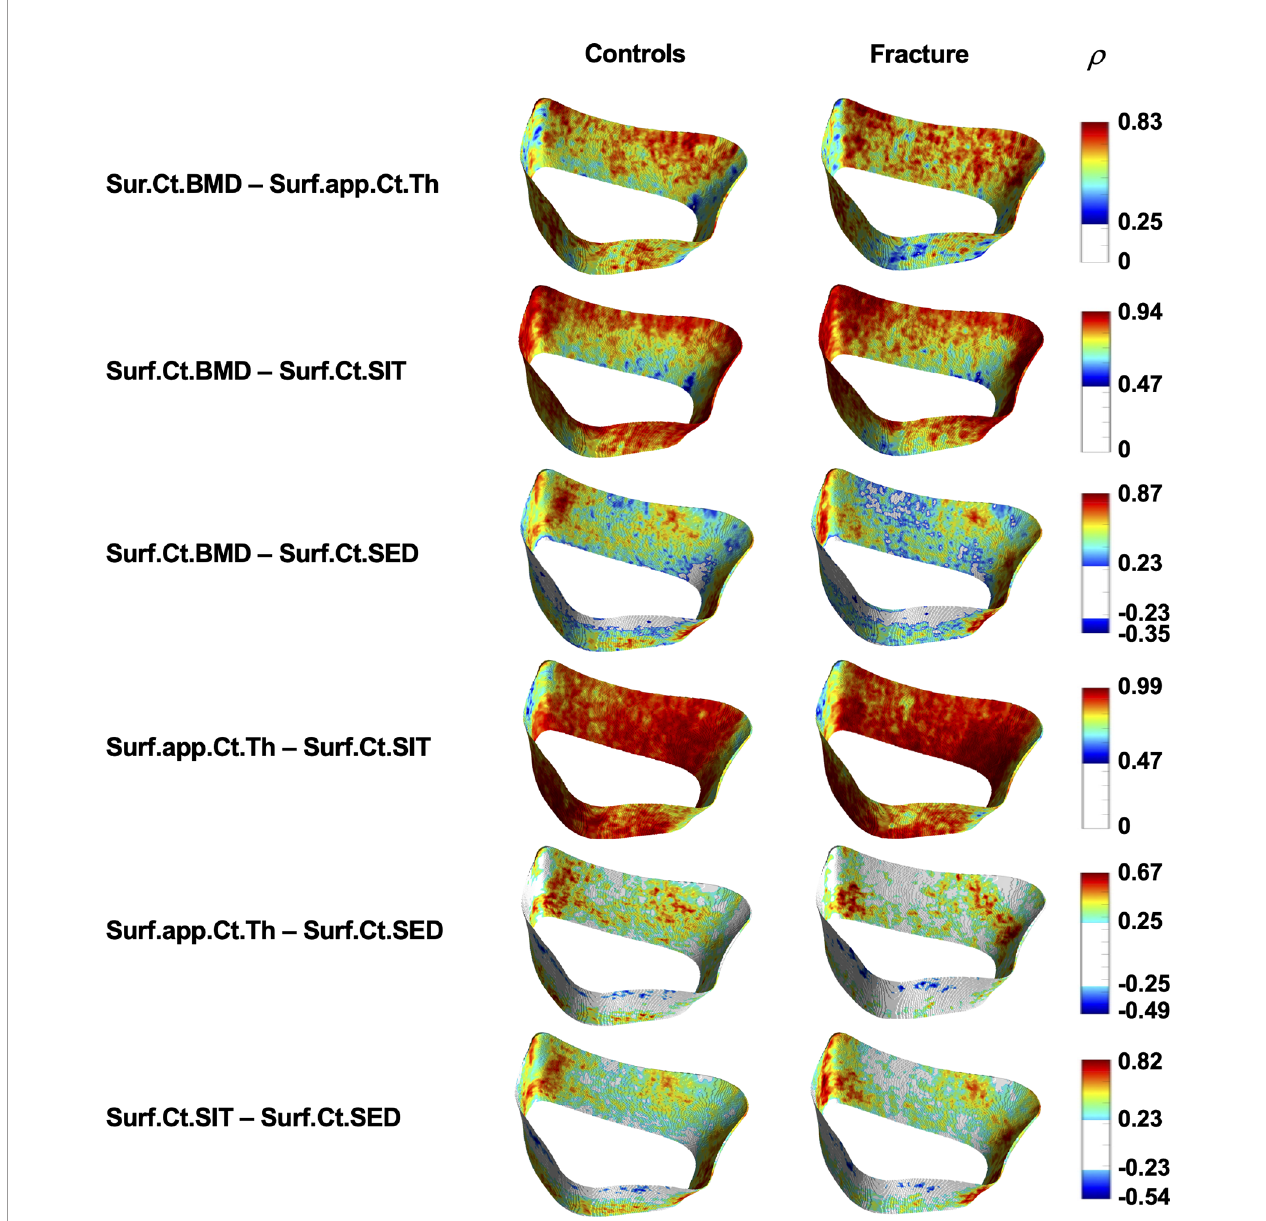
FIGURE 5 | Spatial assessment of interrelationships of cortical bone parameters. Surface statistical maps showing Spearman ’ s rank partial correlation coef fi cients for the different interrelationships of cortical bone parameters for controls and fracture cases. All maps were adjusted for age, height, weight, and shape. Vertices that were no signi fi cant after correcting for multiple comparisons are shown in white. r = Spearman ’ s rank partial correlation coef fi